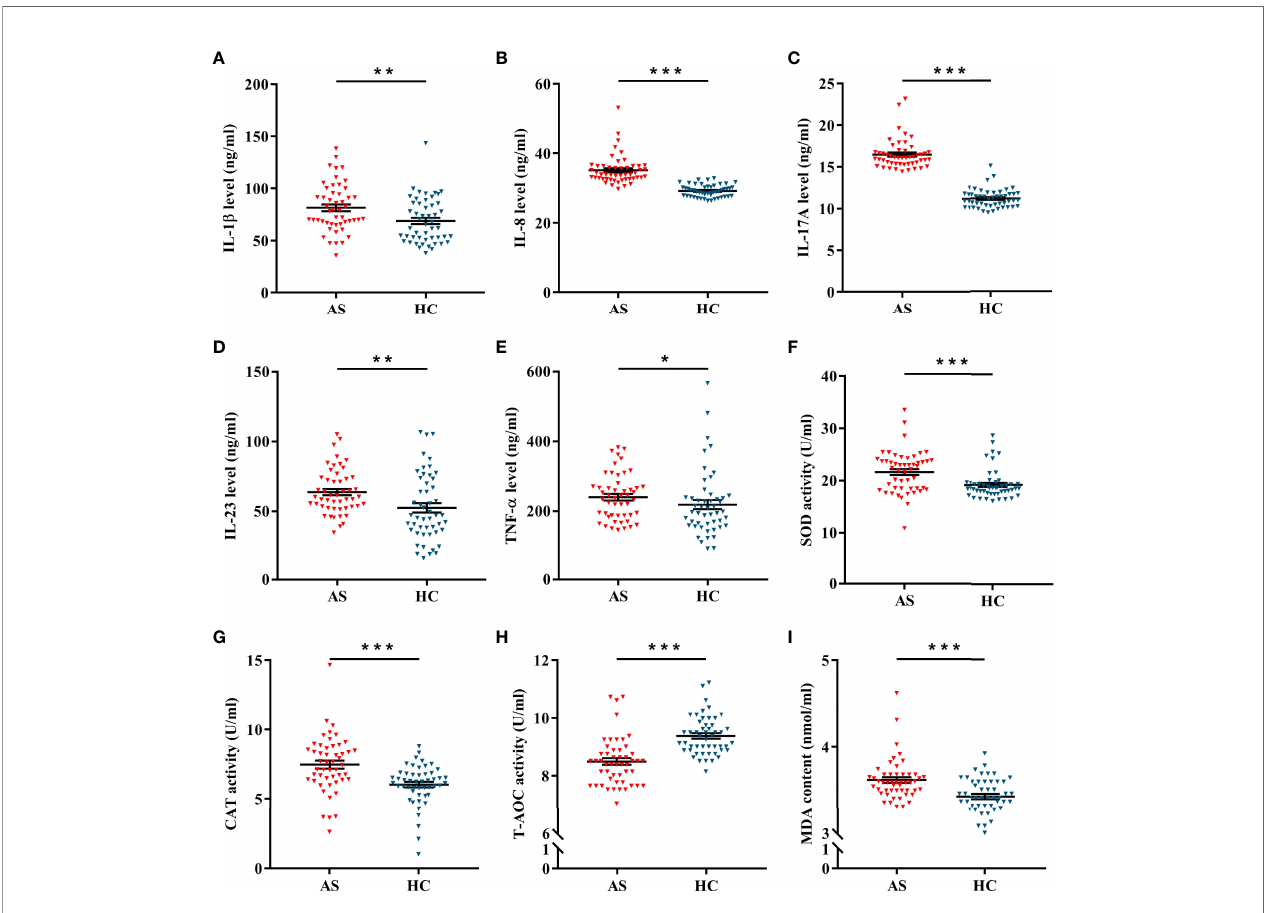
FIGURE 2 | The levels of in fl ammation and oxidative stress in AS and HC. (A – F) The expression of IL-1 b (A) , IL-8 (B) , IL-17A (C) , IL-23 (D) and TNF- a (E) between AS (n = 50) and HC (n = 50). (F – H) The activities of SOD (F) , CAT (G) , and T-AOC (H) between AS and HC. (I) The content of MDA between AS and HC. All data were expressed as mean ± SEM . The differences between AS and HC were analyzed using Mann-Whitney U test. * P < 0.05, ** P < 0.01, *** P < 0.001. AS, ankylosing spondylitis; HC, healthy